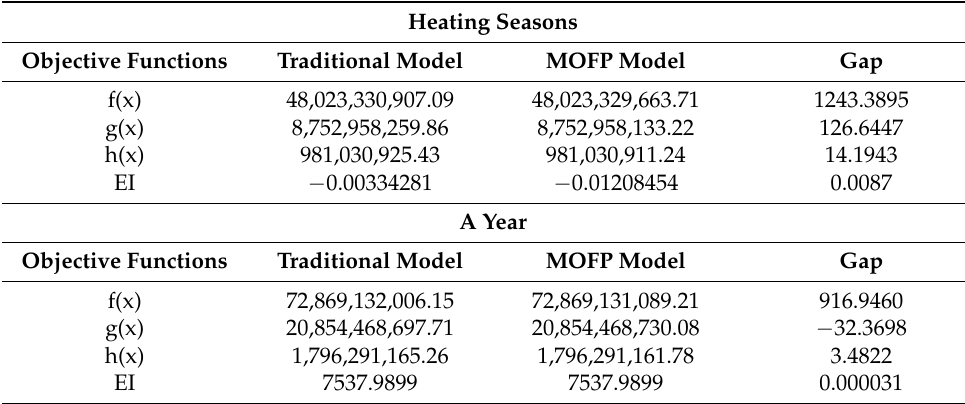
Table 3. The comparison between two